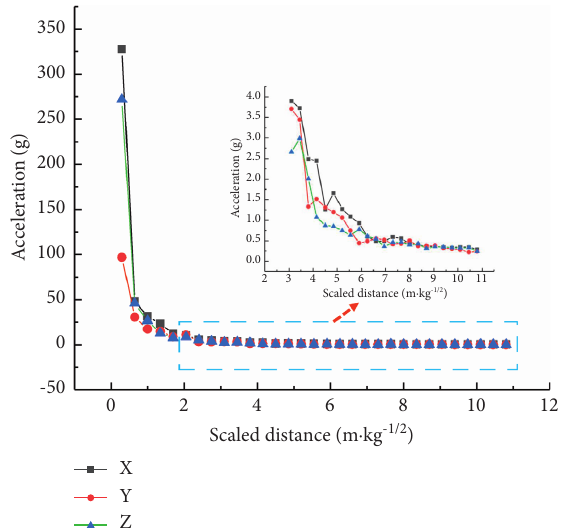
Figure 13: Three-directional acceleration curves of peripheral